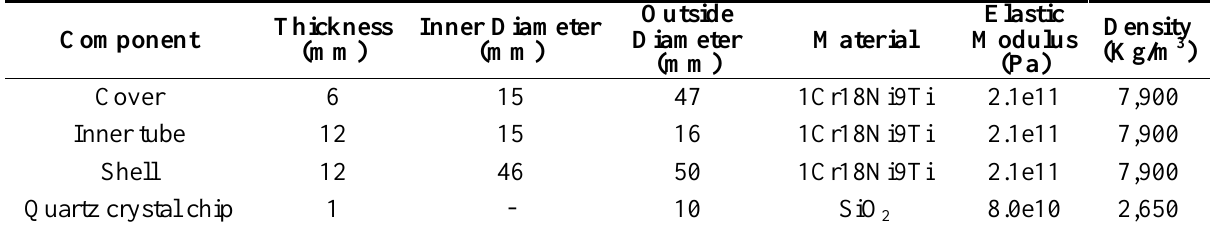
Table 1. Main structural parameters of six-axis force sensor